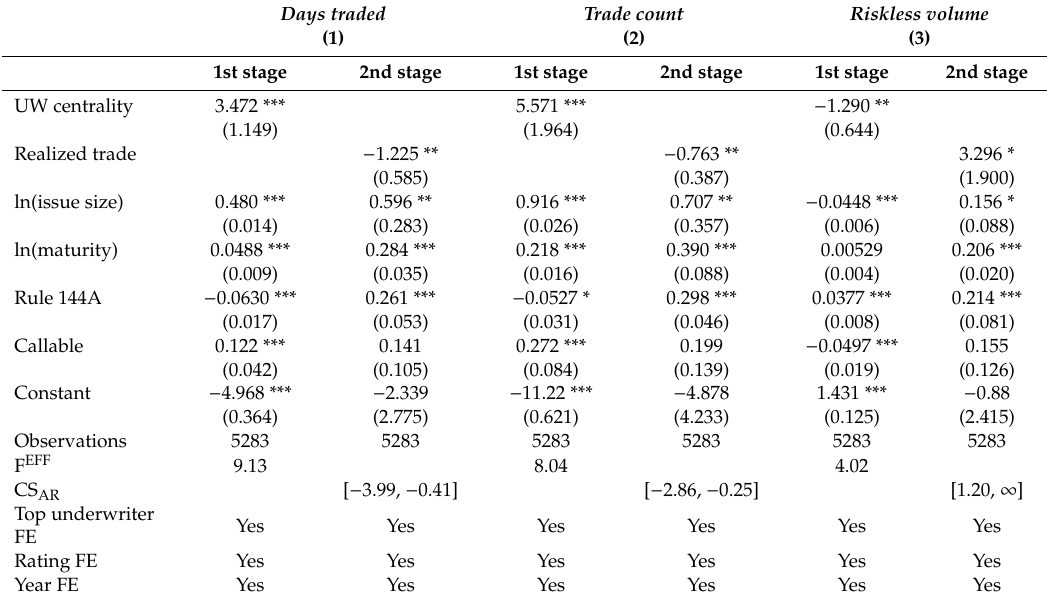
Table 8. IV Regressions for O ff ering Yield Spread Including Underwriter Fixed E ff